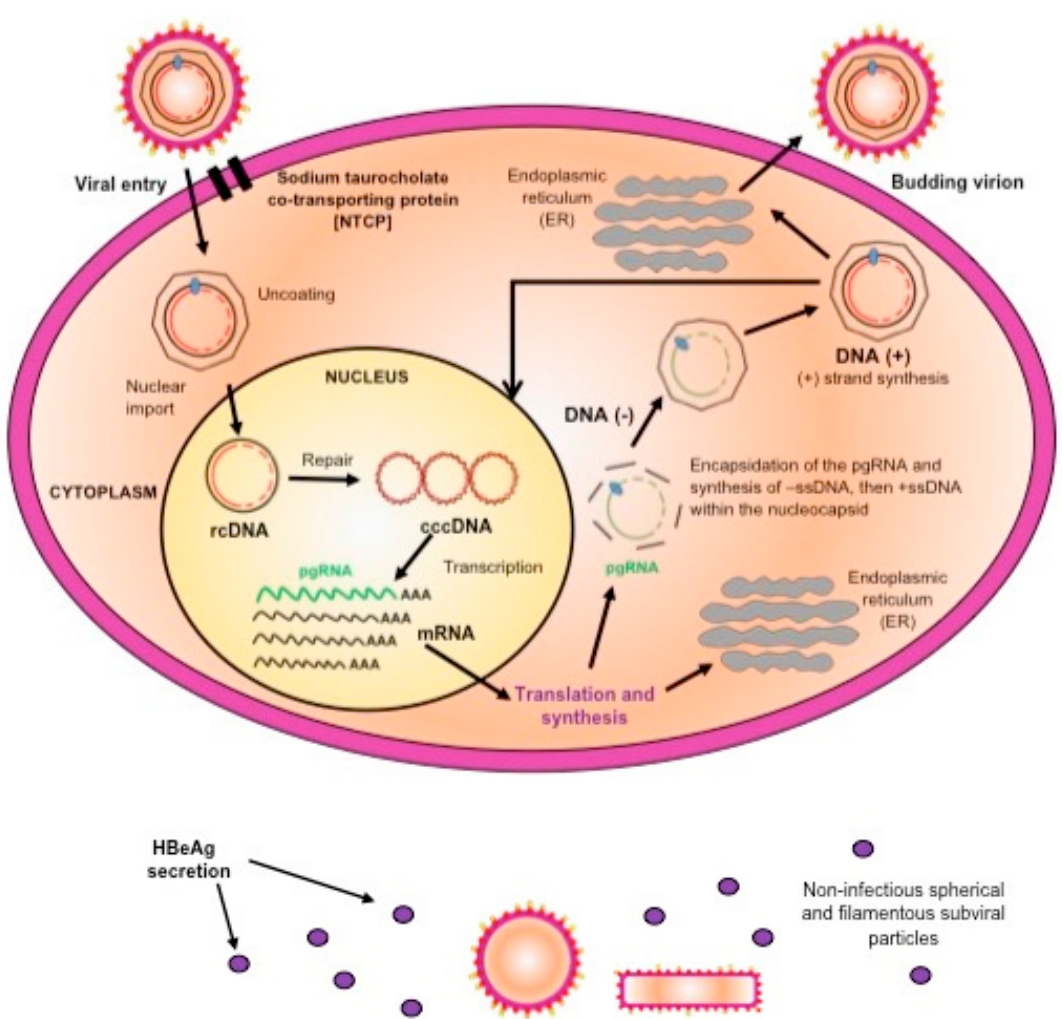
Figure 1. A schematic representation of the replication cycle of hepatitis B virus (HBV).